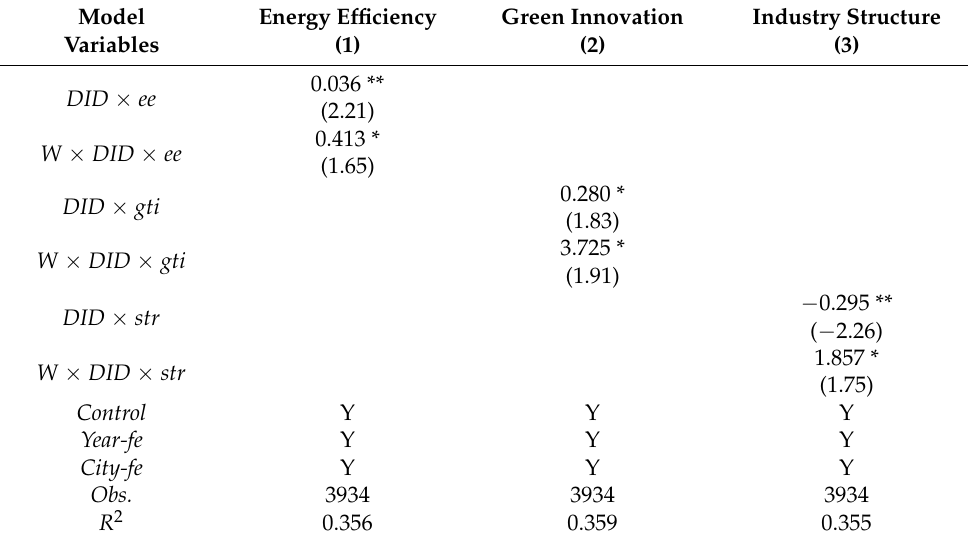
Table 2. Results of the impact mechanism